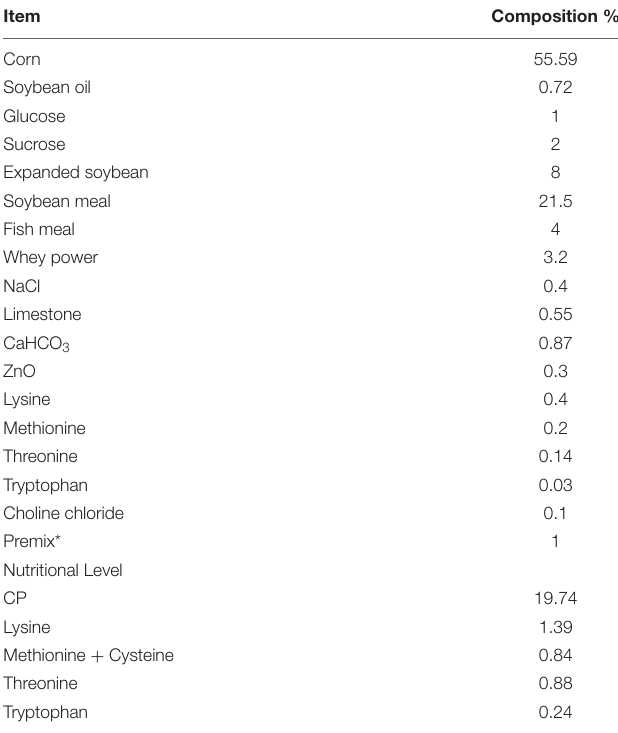
TABLE 1 | Composition and nutrient level of basal